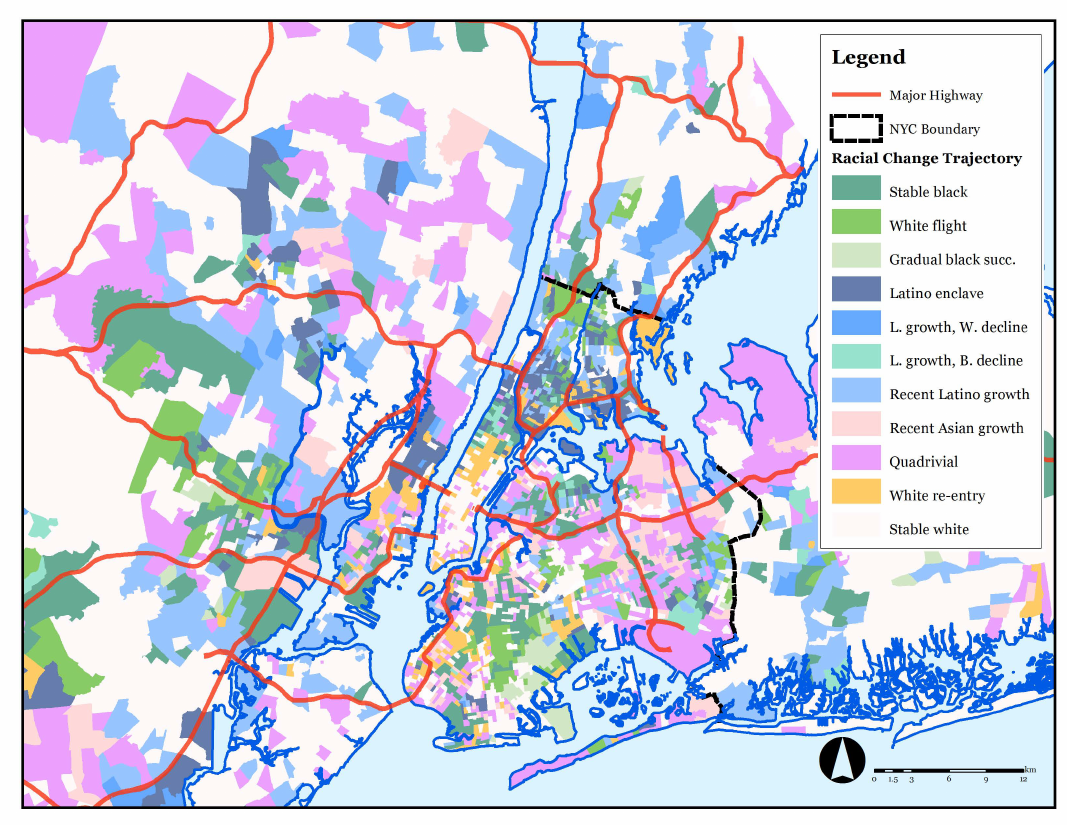
Figure 3: Map of neighborhood racial change trajectories from 1970–2010 in the New York metropolitan area (map shows a detail of neighborhoods in and near New York City; a map of the complete CMSA is available upon